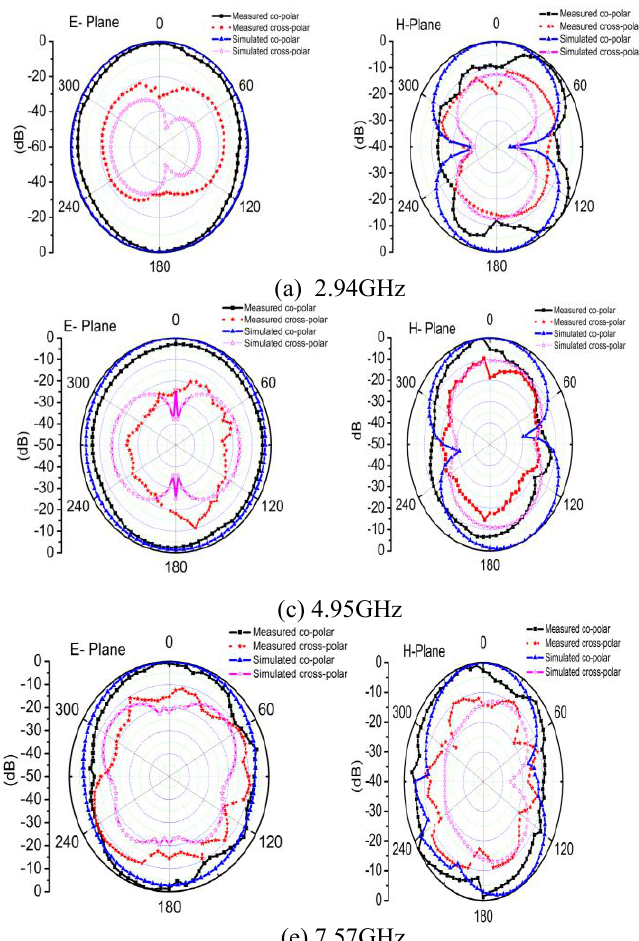
Figure 9: Measured 2D radiation pattern at various resonant frequencies 2.2. Compact planar CPW fed UWB antenna with reflector